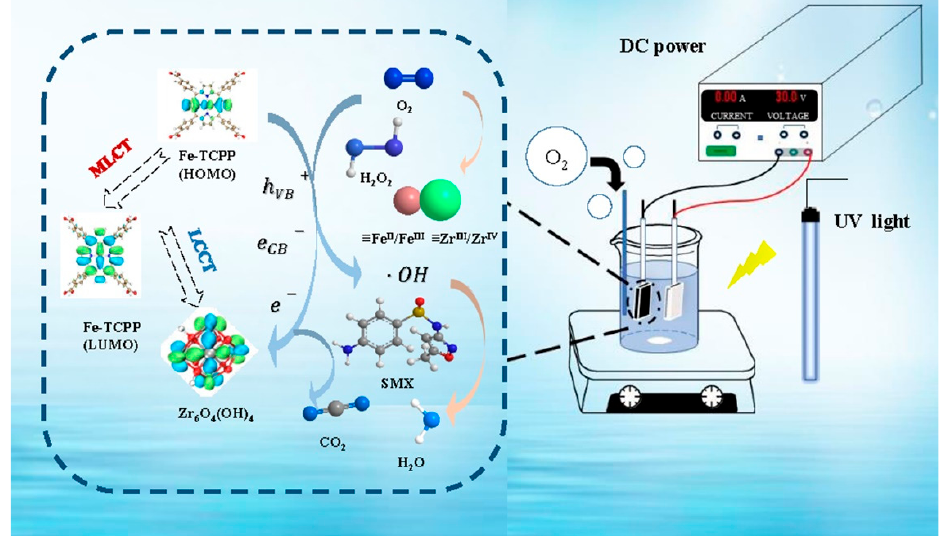
Figure 9. Mechanism diagram of SMX degradation in PEF